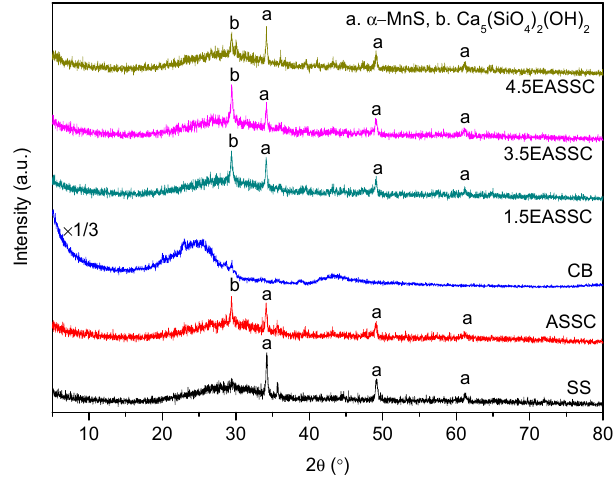
Figure 2. XRD patterns of samples.